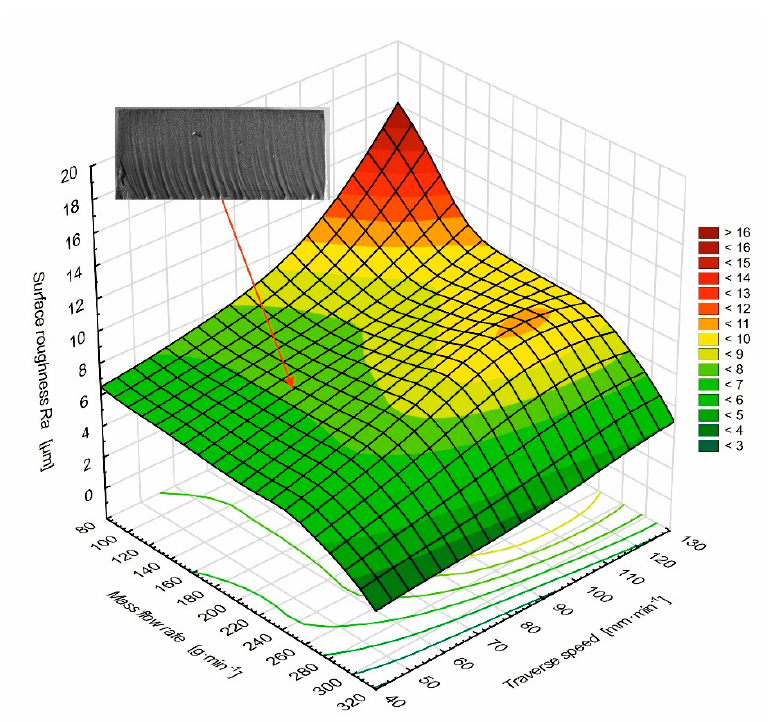
Figure 7. Dependence of surface roughness Ra on the variation of cutting head feed rate and abrasive mass flow.